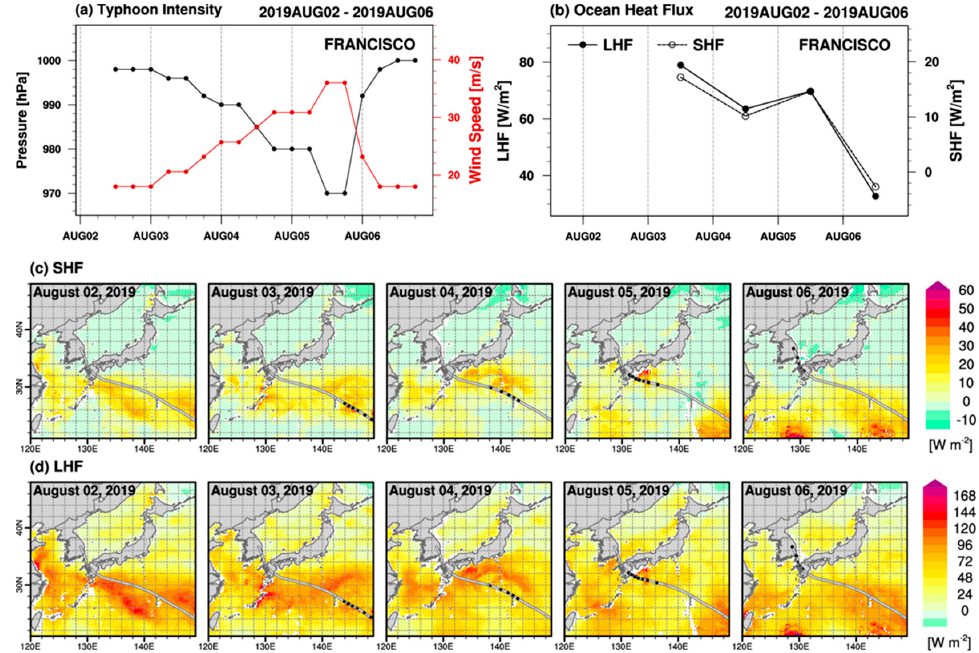
Figure 9. Time series of ( a ) typhoon intensity (central pressure and wind speed) and ( b ) LHF and SHF, which were averaged for the area within 2° of the center; and spatial distribution of daily mean ( c ) LHF and ( d ) SHF during typhoon Francisco, 2019. Gray lines are typhoon trajectory.